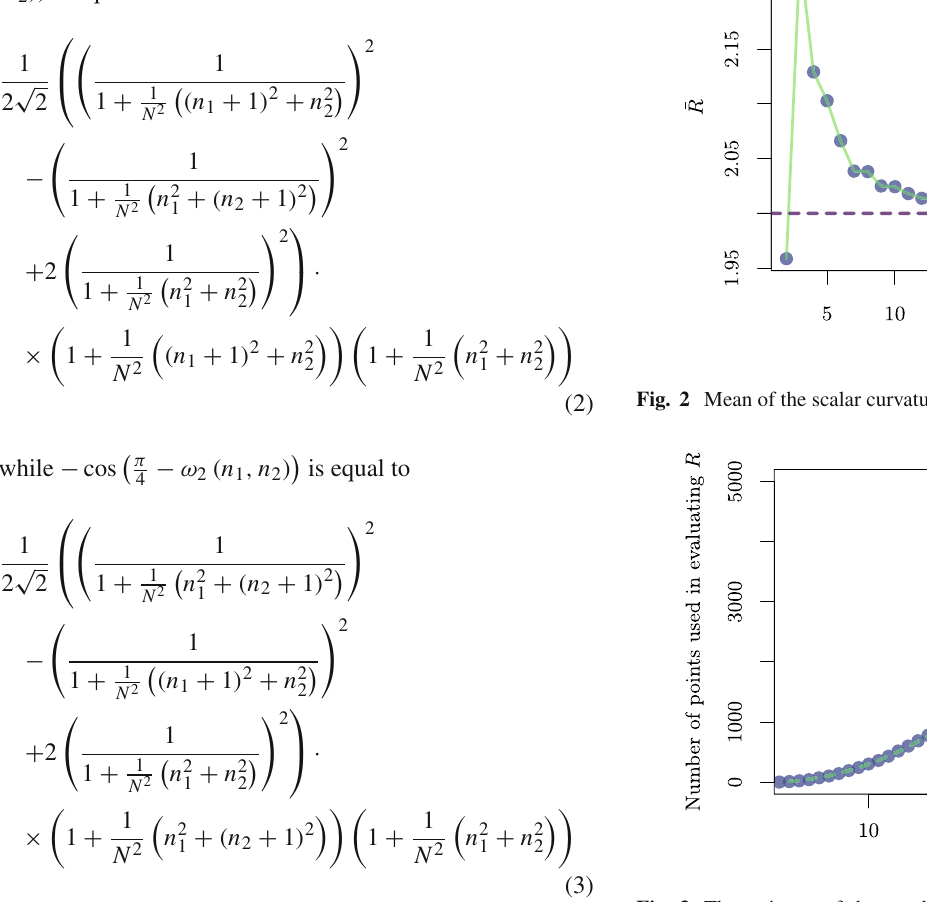
point ( 0 , 0 ) is at the pole, and the points satisfying ( n 12 + n 22 = N 2 ) are at the equator. However, the number of points entering in the computation of the spin connections (given in terms of the zweibein at the lattice point ( n + 1 ) ) and the curvature tensor (found in terms of ω( n + 1 ) ) is